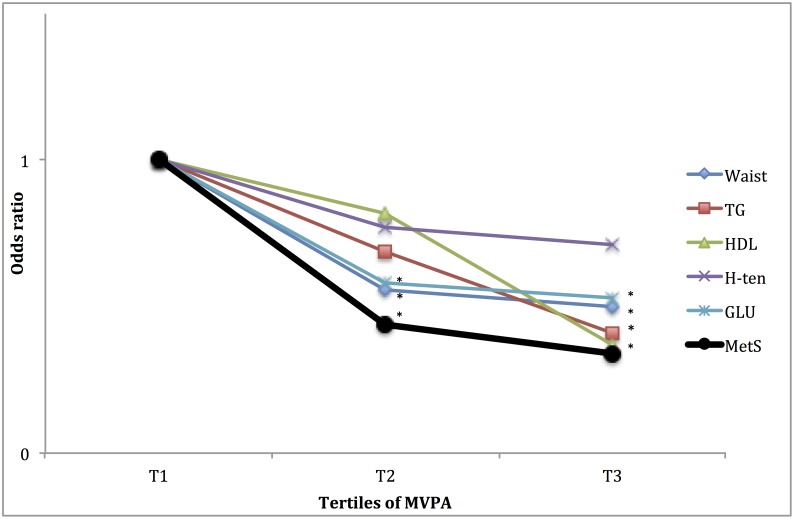
Relationship between tertiles of MVPA and for unfavourable sub-components of METs.ORs are adjusted for gender, age, education level (university degree vs. not), energy intake (kcal·d-1 in quartiles), smoking habits (regular smoker vs. not) and psycho-social stress (self-reported into four levels), % of wear time spent in SED (in tertiles), and estimated VO2max (ml·min-1·kg-1, in tertiles). * Denotes significant difference to reference group.